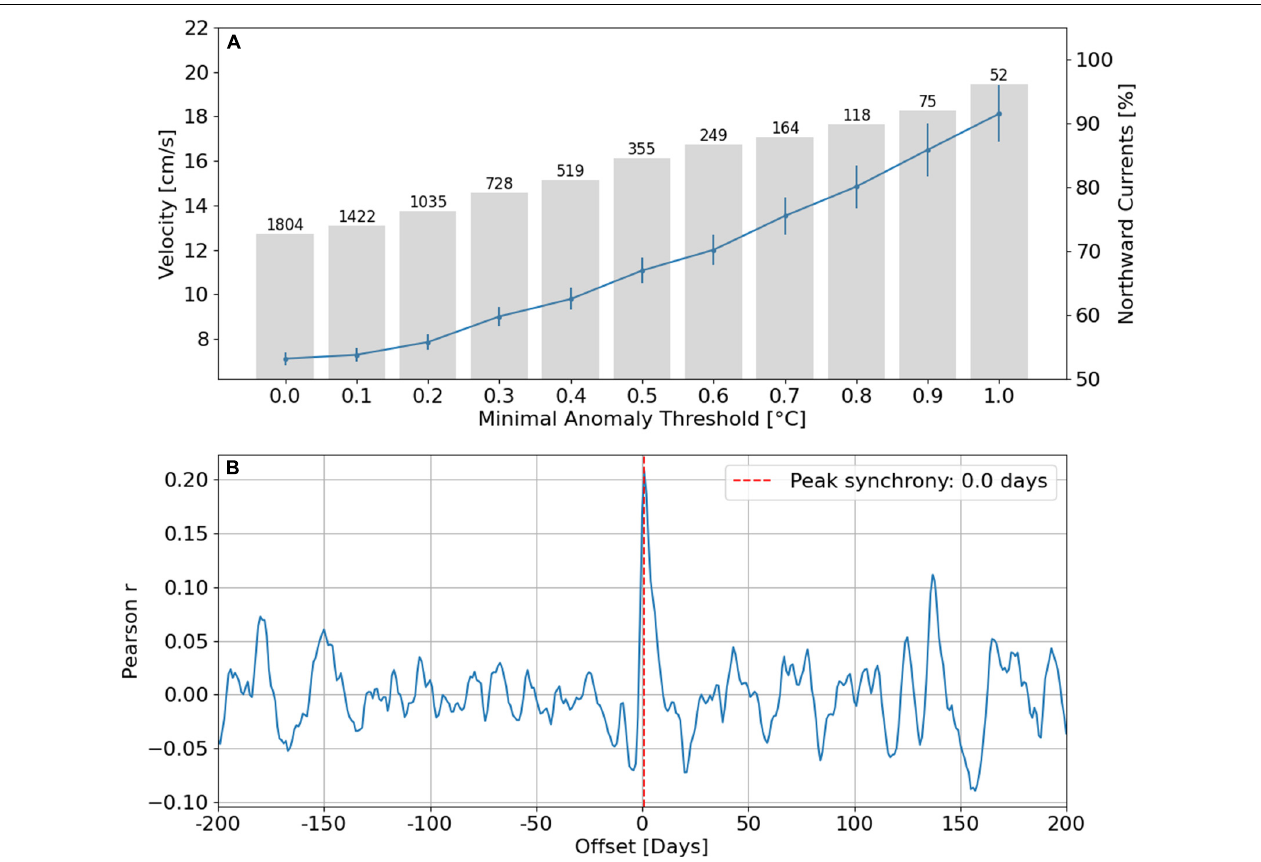
FIGURE 9 | Correspondence between along shore currents and positive temperature anomalies. (A) The along shore current time series is filtered for increasing positive temperature anomaly thresholds (shown in the X axis). The resulting filtered along shore current dataset is averaged (blue line, vertical bars show standard error) and the percentage of incidents where northward currents coincide with the positive temperature anomaly is calculated (gray bars, total number of data points above the temperature threshold). (B) Lag correlation between temperature and along shore current residuals time series. Peak synchrony marked by red dashed